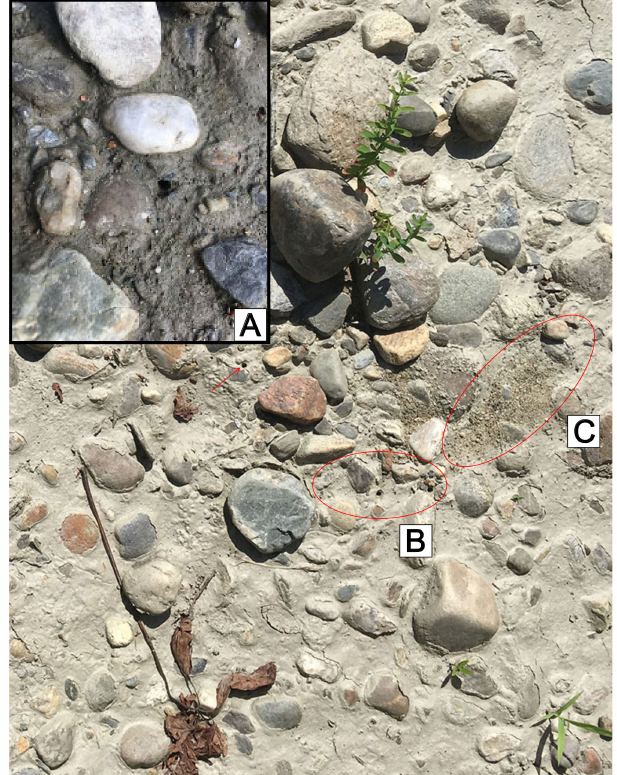
Figure 7. C. marginipennis larval burrows are di ffi cult to detect amid heterogenous cobble habitats. Burrow mouths can blend in with shadows, with substrate and occur at acute angles as in ( A ). Visually searching for a “throw pile” of soil excavated and ejected from larval burrows is easier to detect for this species ( C ), which can be connected to one or several adjacent burrows ( B ). Following the visual cue of a “throw pile” ( C ) can lead to detecting one or several burrows ( B ). Close investigation of the area in B reveals three adjacent burrows, and a fourth burrow at the upper